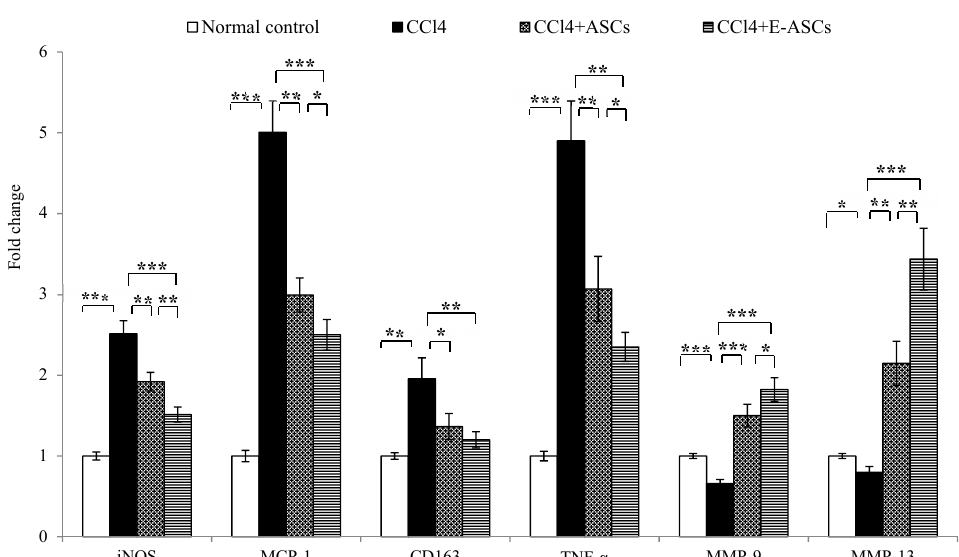
0123456 Figure 6. Gene expression in hepatic tissues for rats of different groups. Quantitative RT-PCR was used to evaluate the gene expression in hepatic tissues for rats of different groups. Data represent fold change relative to the normal control group expression after normalization to glyceraldehyde 3-phosphate dehydrogenase (GAPDH). Bars represent mean ± SD. Significant difference between groups is analyzed by a one-way ANOVA test, where: *: p < 0.05, **: p < 0.01 and ***: p < 0.001. ASCs: adipose tissue-derived mesenchymal stem-like cells, E-ASCs: adipose tissue-derived mesenchymal stem-like cells preconditioned with eugenol, CCl4: carbon tetrachloride, iNOS: inducible-nitric oxide synthase, MCP-1: monocyte chemoattractant protein-1, CD163: cluster of differentiation 163, TNF- α : tumor necrosis factor- α , MMP: matrix metallopeptidase. Figure 7. Histological examination of hepatic tissues for rats of different groups. Hepatic tissues were stained with hematoxylin–eosin staining. ( A ) Normal control group, ( B ) fibrotic (CCl4) group, ( C ) CCl4+ASCs group and ( D ) CCl4+E-ASCs group, magnification: ×100. ASCs: adipose tissue-derived mesenchymal stem-like cells, E-ASCs: adipose tissue-derived mesenchymal stem-like cells preconditioned with eugenol, CCl4: carbon